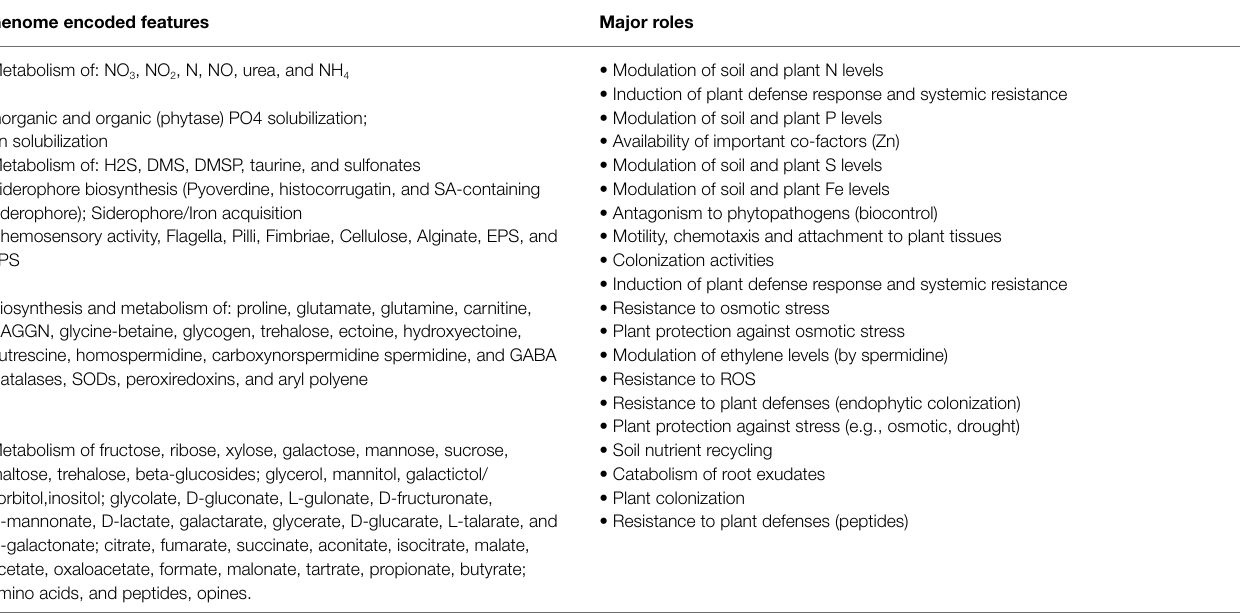
TABLE 2 | Features encoded in the P. thivervalensis SC5 genome and their roles in plant growth promotion, plant-microbe interactions, and phytopathogen antagonism. Detailed analysis of genes can be found in Supplementary Tables S1–S15 . Genome encoded